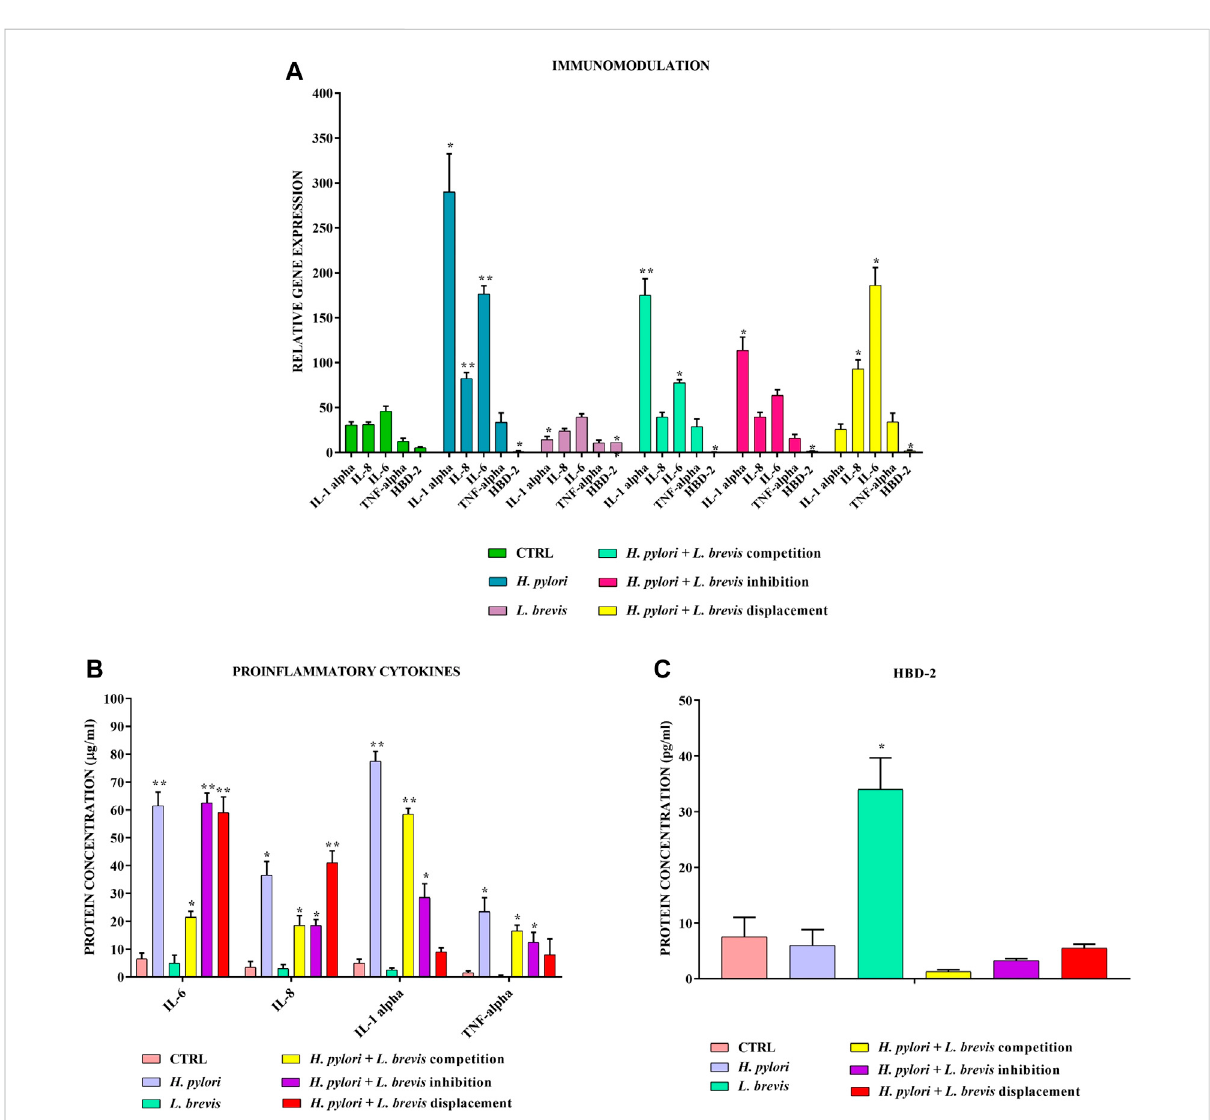
FIGURE 3 Real-Time PCR (A) and ELISA (B,C) show the expression levels of pro-in fl ammatory cytokines and HBD-2 in AGS cells infected with H. pylori and/or L. brevis SP48. Data are expressed as relative mRNAs expression (A) and protein concentration (B,C) in each group and are representative of three different PCR and ELISA experiments ±SD. RNA was extracted from 3different AGS cell samples treated with the same batch of H. pylori and L. brevis . Signi fi cant differences are indicated by * p < 0.05, ** p < 0.01, and *** p <